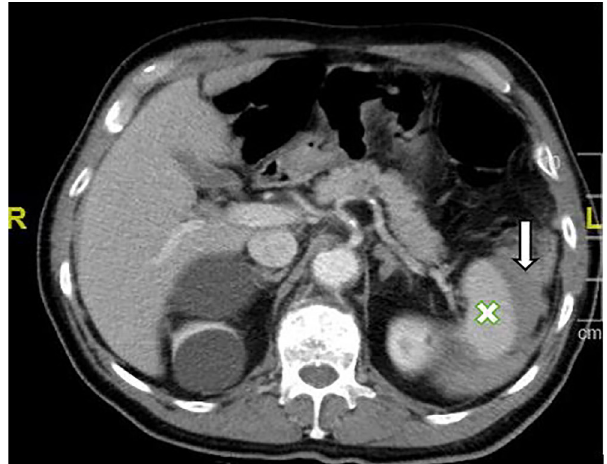
Image 2. Computed tomography of the abdomen and pelvis with intravenous contrast depicting a perisplenic hematoma (arrow) with small amounts of blood products extending into the intraperitoneal space from the spleen